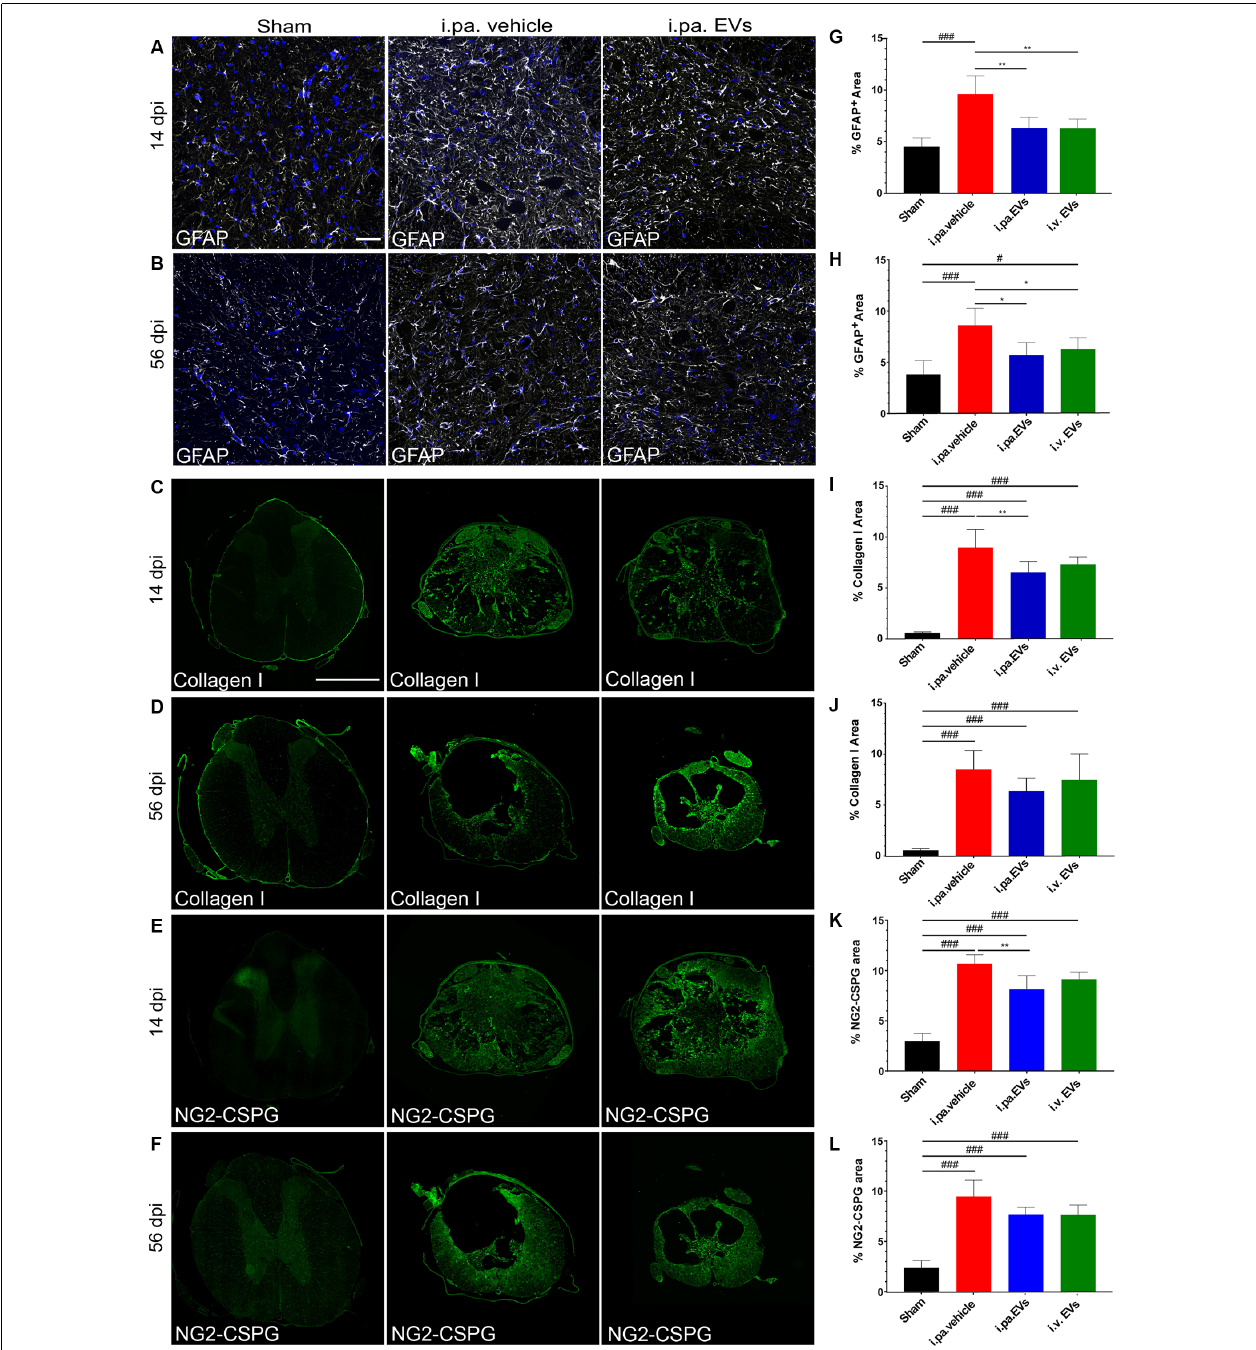
FIGURE 3 | Acute intralesional application of EVs reduced astrogliosis and scarring after tSCI. Immunodetection of GFAP (A,B) , collagen I (C,D) , and NG2 (E,F) in the spinal cord of a sham rat and following tSCI. (A,B) Immunodetection of GFAP-expressing astrocytes (white) in the ventral horn of sham rats, i.pa. vehicle-treated tSCI rats and i.pa. EVs-treated tSCI rats at 14 days (A) and 56 days (B) post-injury (3 mm rostral from lesion epicenter); Nuclear counterstain with DAPI (blue). Scale bar (A) = 50 µ m. (C,D) Immunodetection of collagen I (green) in the spinal cord of sham rats, i.pa. vehicle-treated and i.pa. EVs-treated rats at 14 days (C) and 56 days (D) post-tSCI at the lesion epicenter. (E,F) Immunodetection of NG-2 (green) in the spinal cord of sham rats i.pa. vehicle-treated and i.pa. EVs-treated rats at 14 days (E) and 56 days (F) post-tSCI at the lesion epicenter. Scale bar (E) = 1,000 µ m. (G,H) Percentage of section area covered by GFAP at 14 days (G) and 56 days (H) post-tSCI. (I,J) Percentage of section area covered by collagen I at 14 days (I) and 56 days (J) post-tSCI. (K,L) Percentage of section area covered NG2 at 14 days (K) and 56 days (L) post-tSCI. Statistical differences to sham group using one-way ANOVA and Tukey post hoc test: ( # ) p < 0.05, ( ### ) p < 0.001, statistical differences to i.pa. vehicle group using one-way ANOVA and Tukey post hoc test on tSCI groups (without sham): ( ∗ ) p < 0.05, ( ∗∗ ) p < 0.01. Days post-injury: